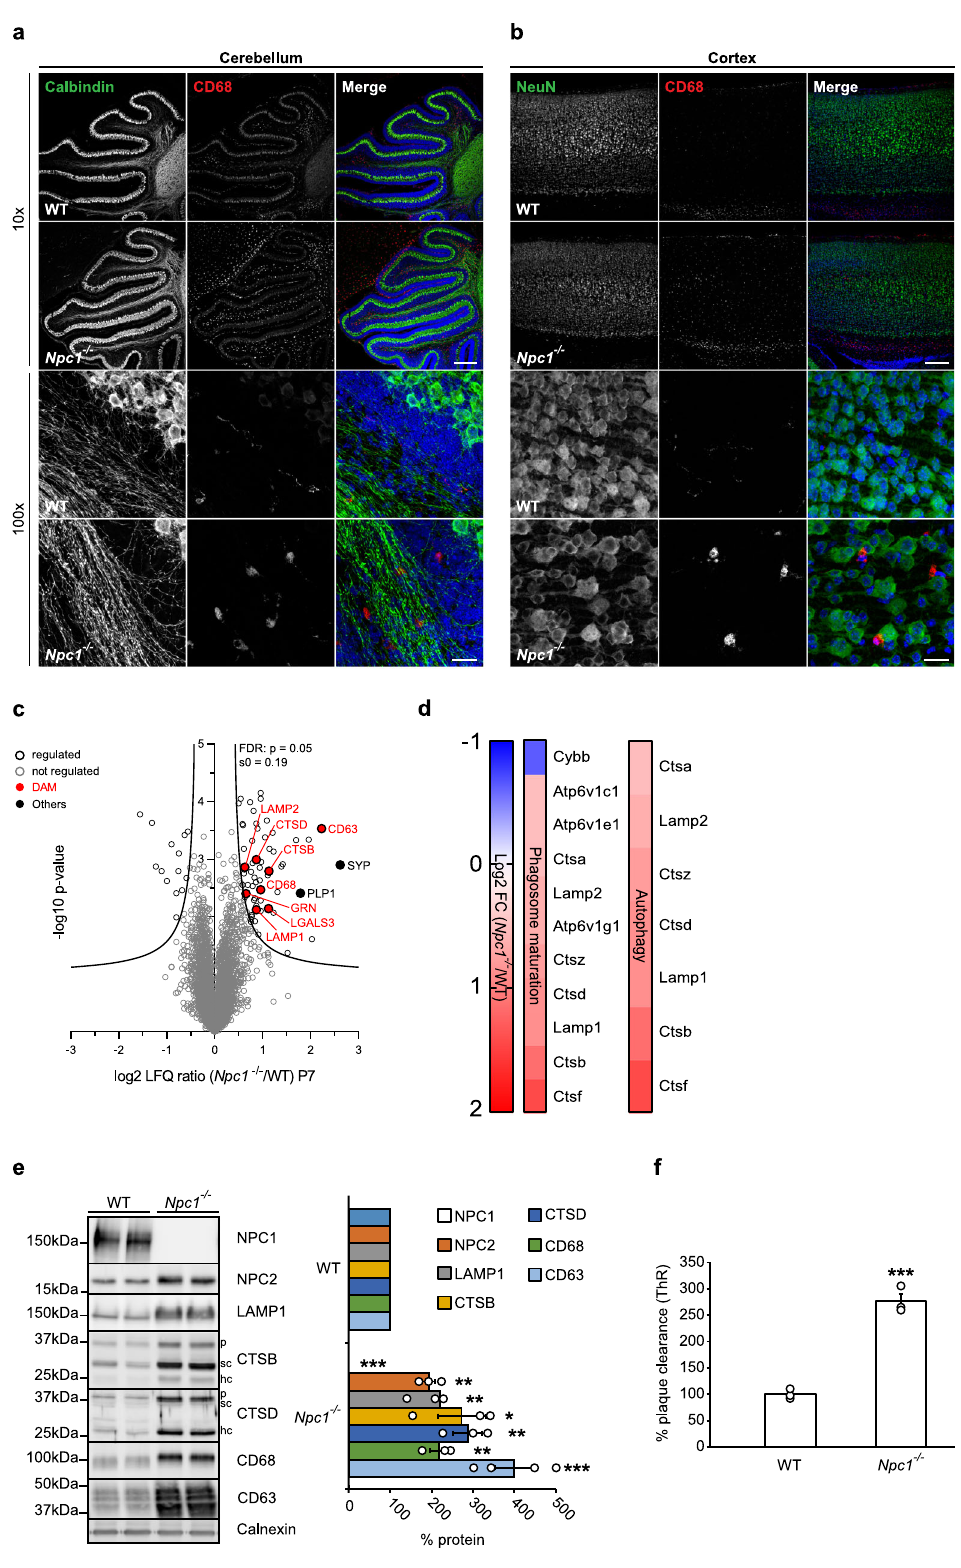
lysosomal traf fi cking and sorting may be among the earliest pathological alterations in Npc1 − / − microglia 67,68 . Of note, CD63 was also increased at symptomatic stage, but as it could only Supplementary Data